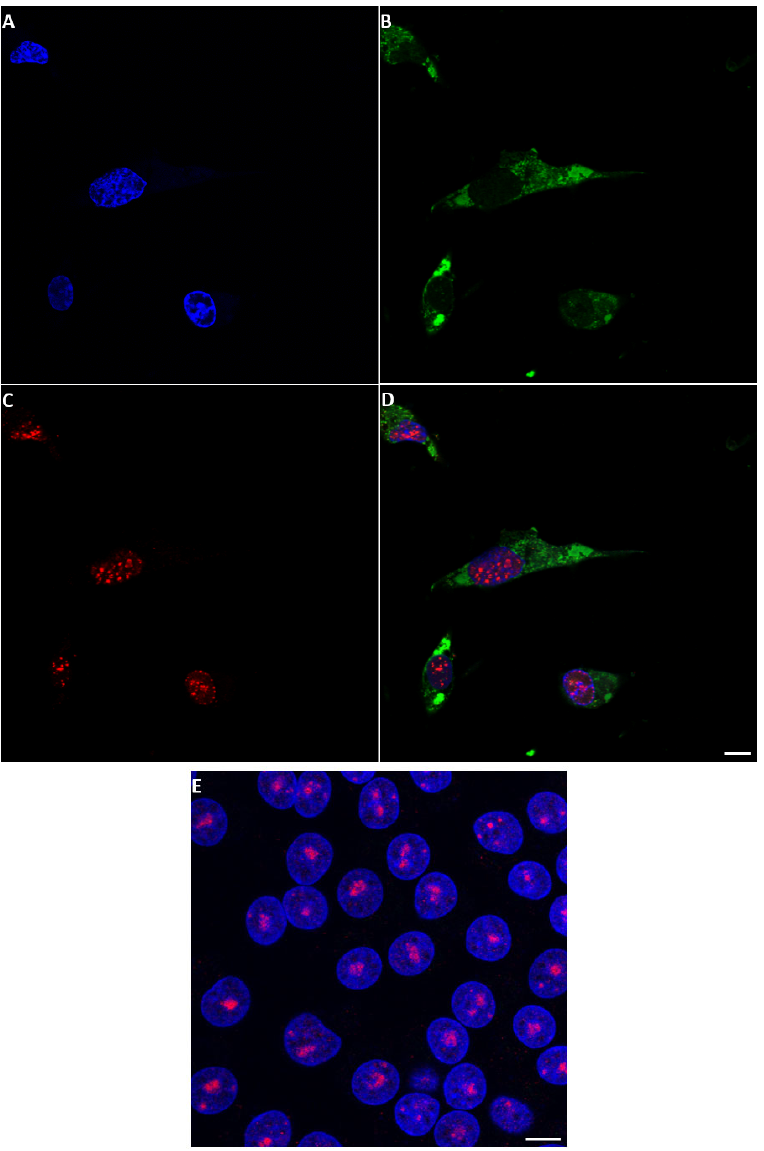
Figure 9. Detection of EHDV-NS5 expression by confocal immunofluorescence microscopy of infected BSR cells. Anti EHDV-NS5 anti-sera identified NS5, mainly in the cytoplasm of EHDV-infected BSR cells. ( A ): EHDV-infected BSR cells stained with DAPI. ( B ): cells probed with anti-EHDV NS5 antibodies and Alexa Fluor 488-conjugated anti-mouse IgG (green). ( C ): cells probed with anti- fi brillarin antibodies and Alexa Fluor 568 anti-rabbit IgG. ( D ): merge of ( A – C ). Panel ( E ) shows non-infected BSR cells stained with DAPI and probed with anti-EHDV NS5 antibodies, Alexa Fluor 488 anti-mouse IgG, anti- fi brillarin antibodies, and Alexa Fluor 568 anti-rabbit IgG. The scale bar repre- sents 5 µm.